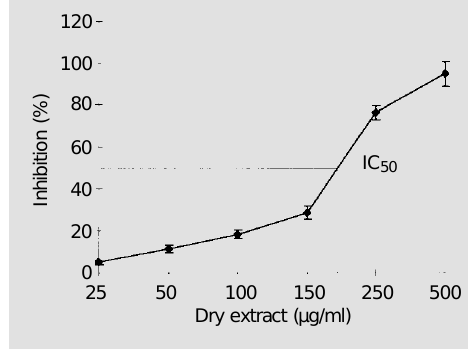
Figure 1 - Antioxidant activity of a methanolic extract of Spirulina